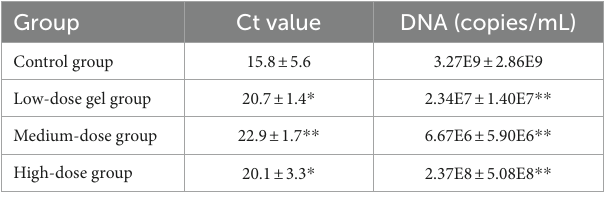
TABLE 3 Effect of chloroquine phosphate gel on HPV6 and HPV11 Ct values and DNA contents of warts in the condyloma acuminatum-bearing nude mouse model ( n = 6 each group).